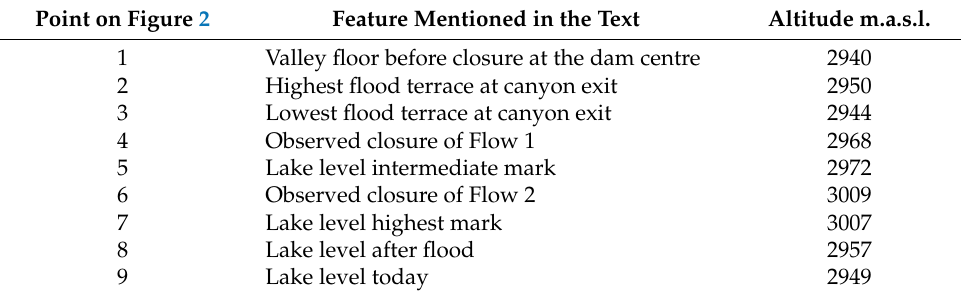
Table 1. Altitudes defined from the detailed topographic survey (Figure